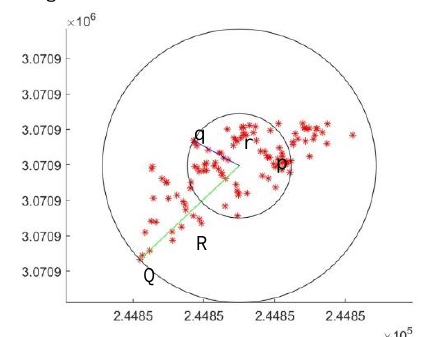
Figure 10. Example diagram of inner and outer circles.